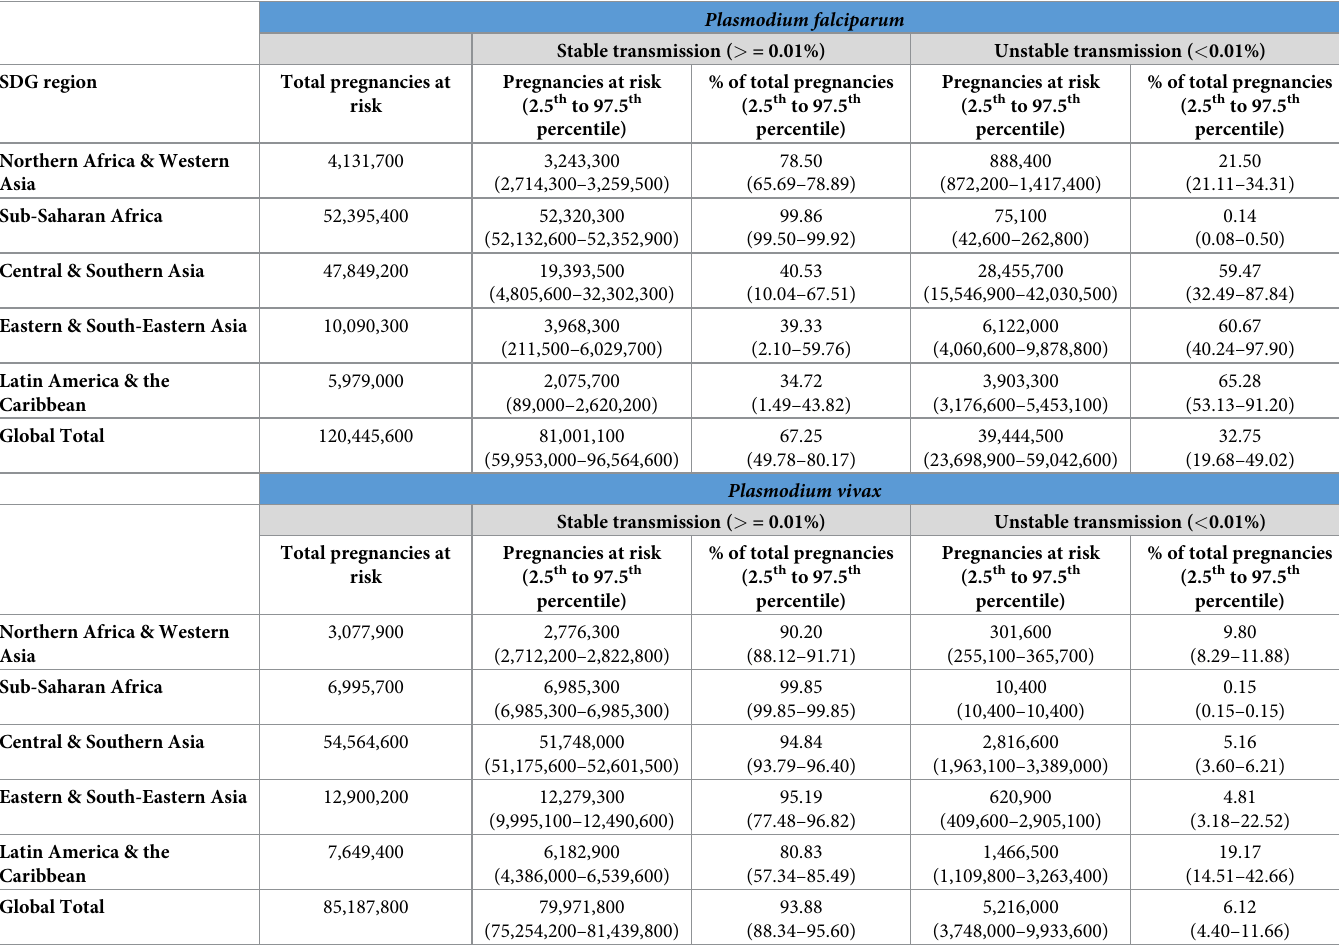
Plasmodium falciparum Stable transmission ( > = 0.01%) Unstable transmission ( < 0.01%)